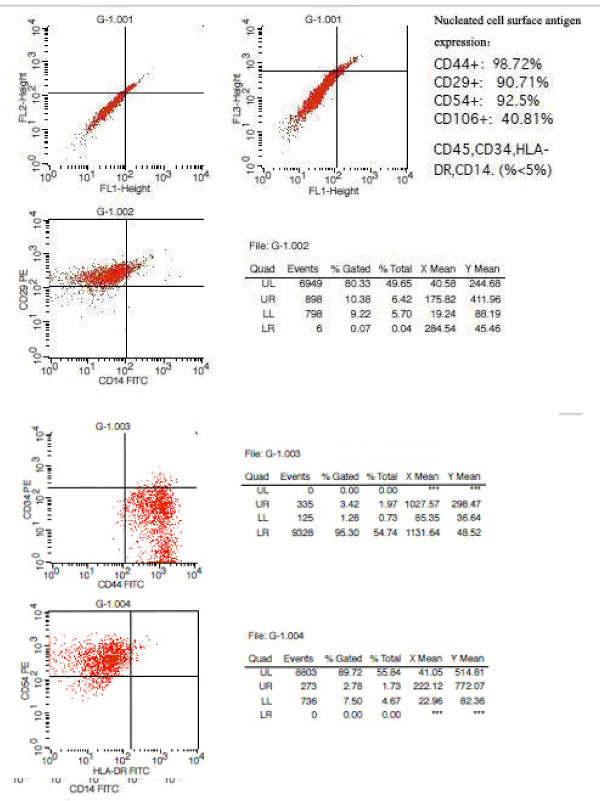
BMSC surface marker detection: CD44 and CD29 positive rates were greater than 95%, the CD106 positive rate was greater than 80%, and the CD34, CD45, CD14, and HLA-DR expression rates were less than 5%.